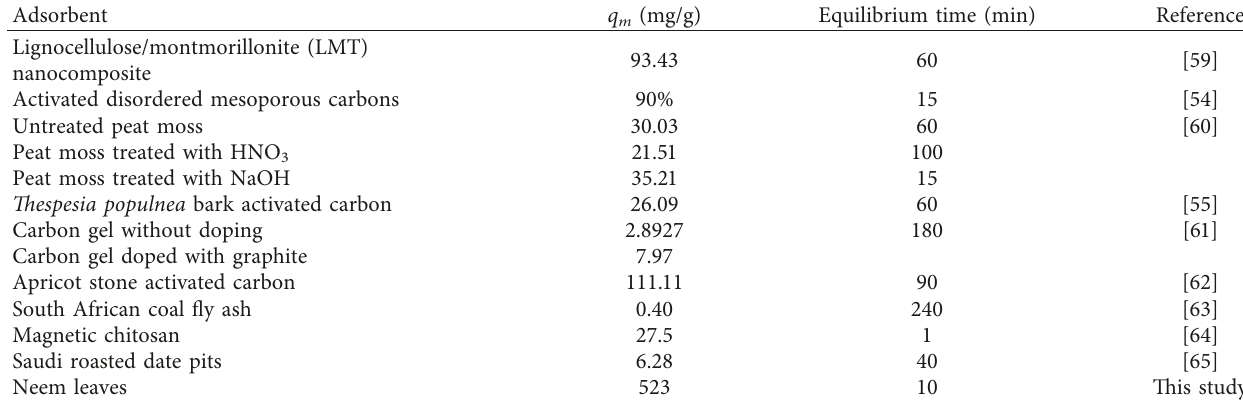
Table 7: Comparison of adsorption capacity of DNL and equilibrium reaction time with other adsorbents for Co(II) adsorption. Adsorbent